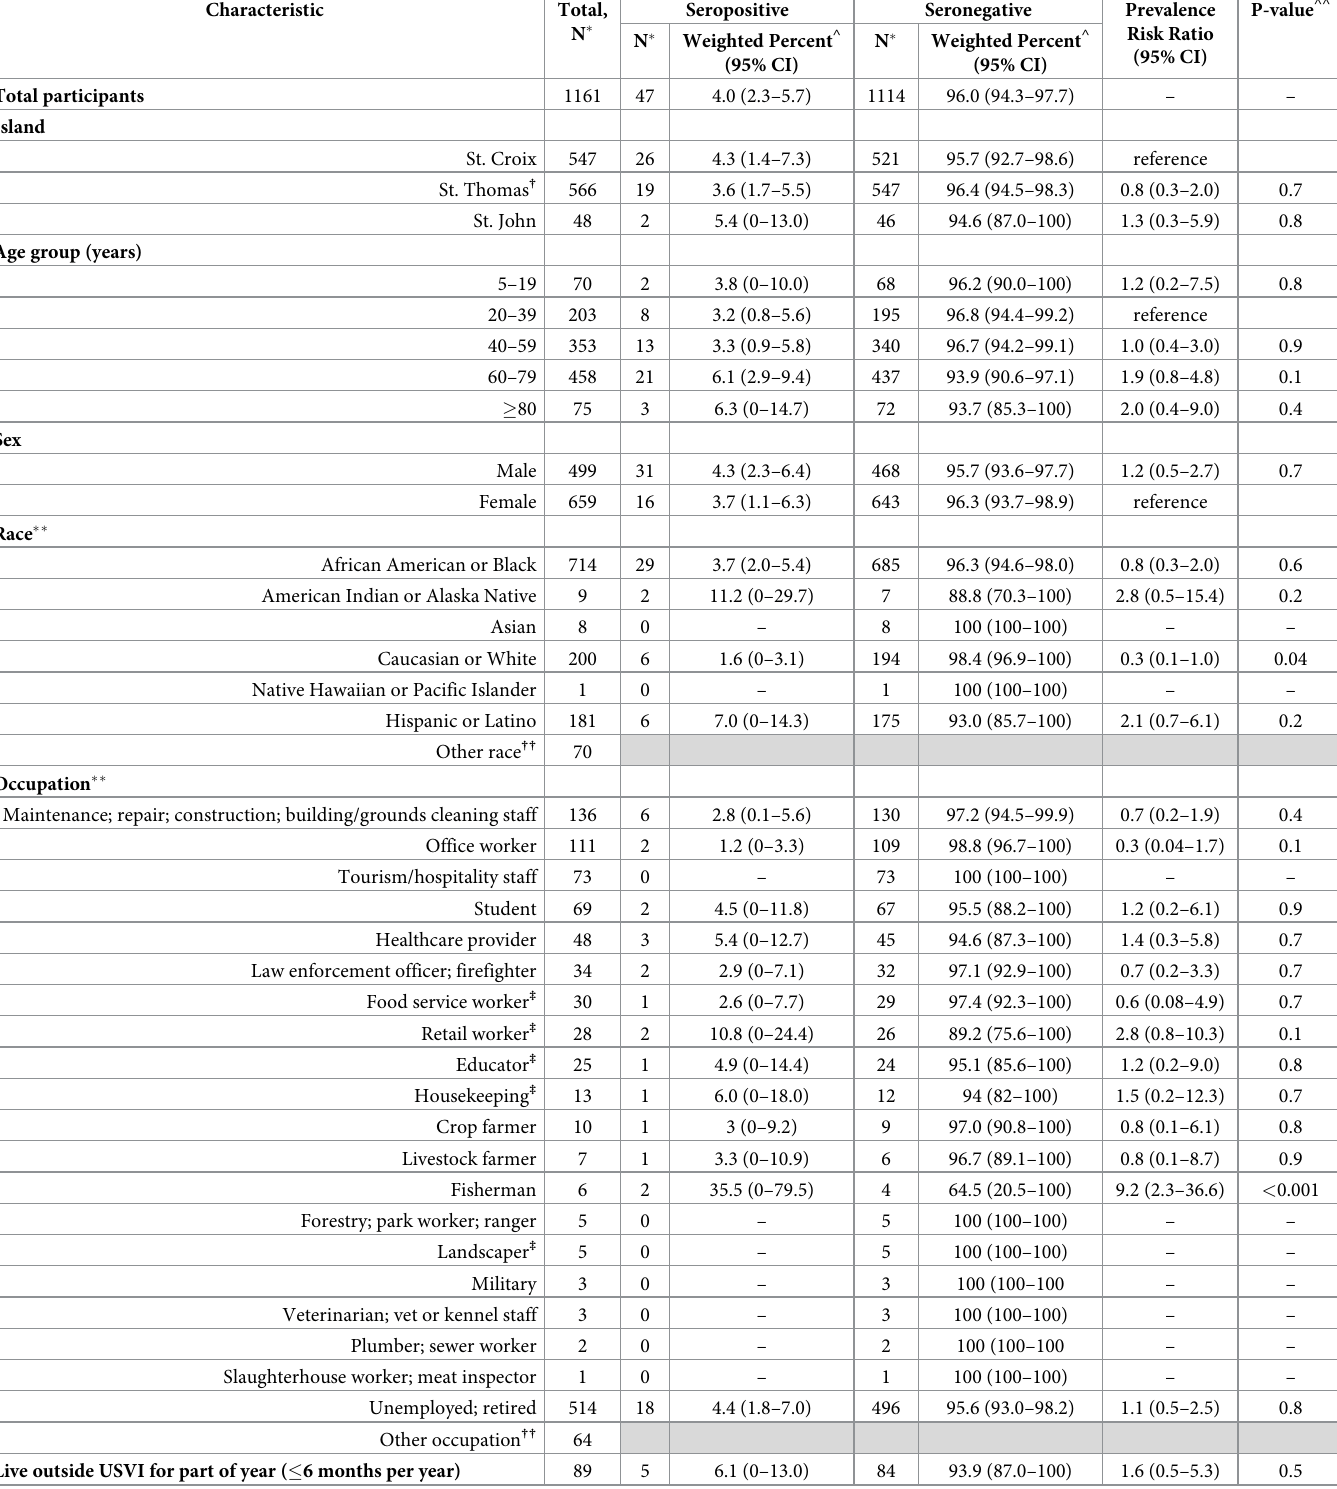
Table 1. Demographic and Travel Characteristics of Leptospirosis Serosurvey Participants in USVI by Serology Result, March 2019.